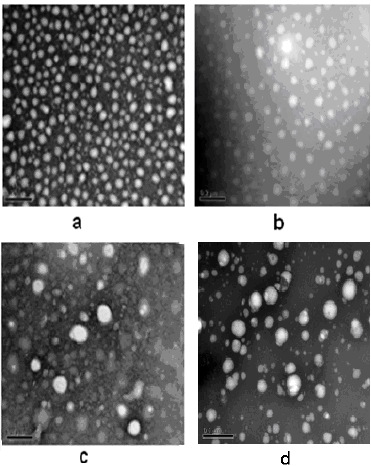
Figure 5. Transmission electron microscopy (TEM) of CHP − 6.91 ( a ), CHP − 6.03 ( b ), CHP − 3.11 ( c ) and CHCP ( d ) nanoparticles.